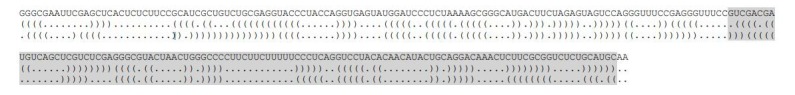
Comparison of the optimal secondary structure predictions of 5i3 and 3e5